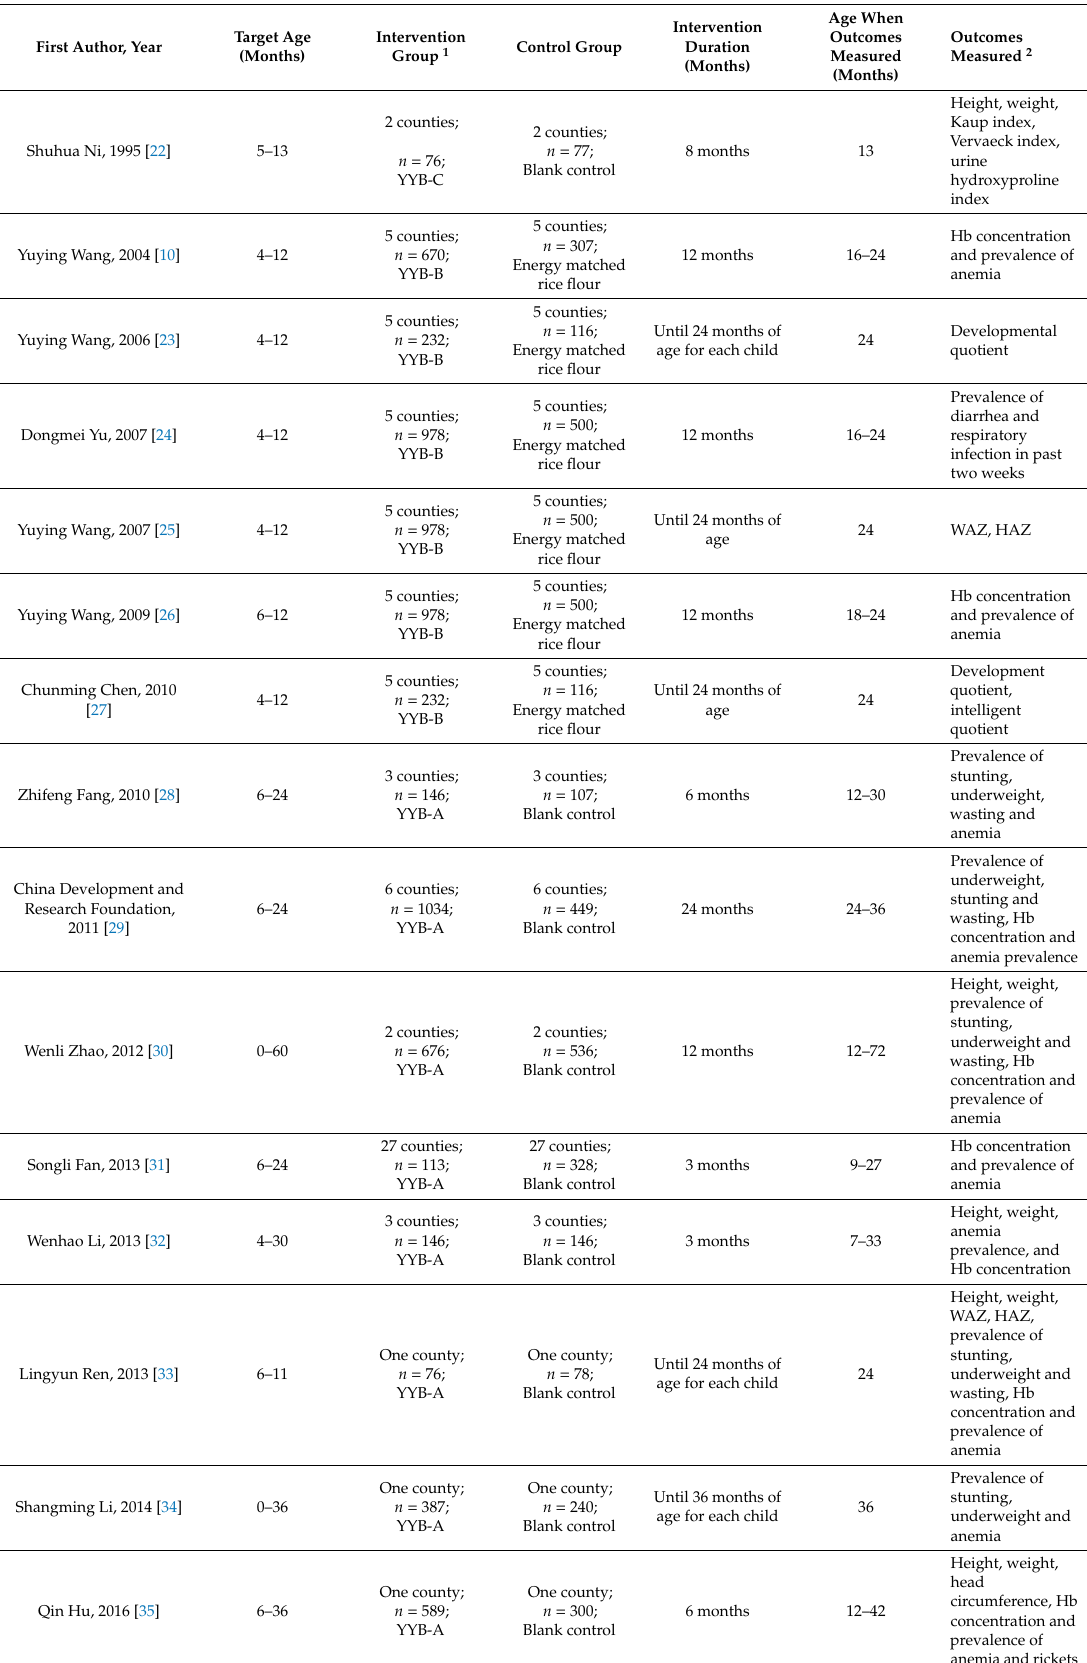
Table 1. Characteristics of post-only studies with